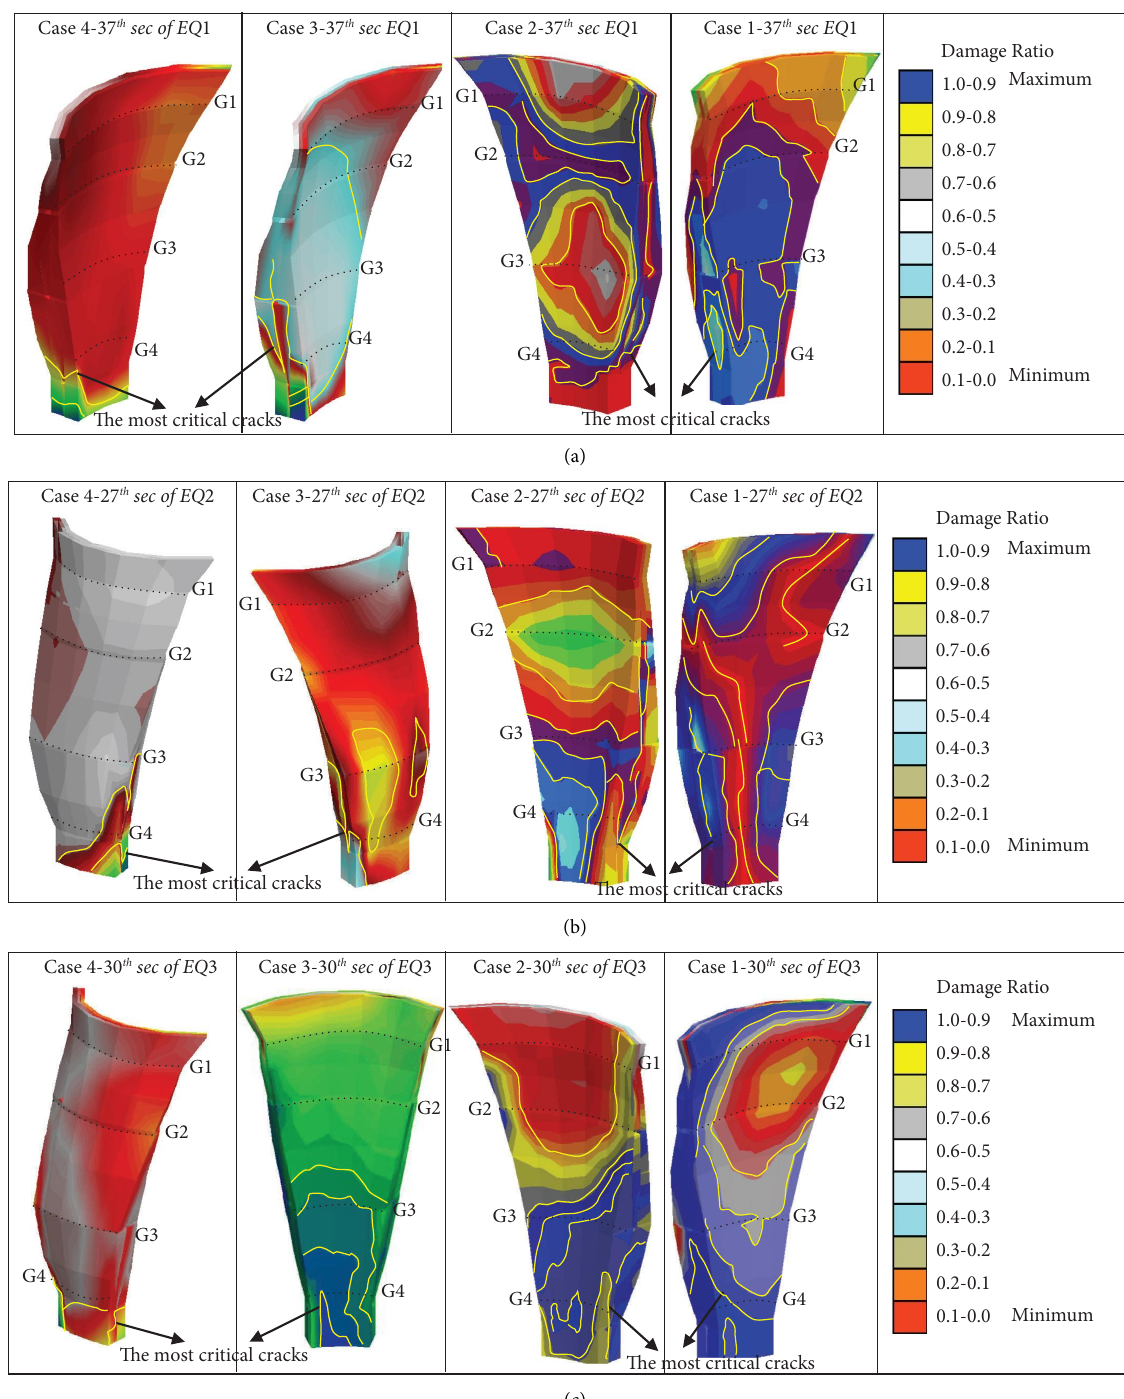
Figure 12: Earthquake crack performance of Ermenek arch dam for (a) EQ1 earthquake, (b) EQ2 earthquake, and (c) EQ3